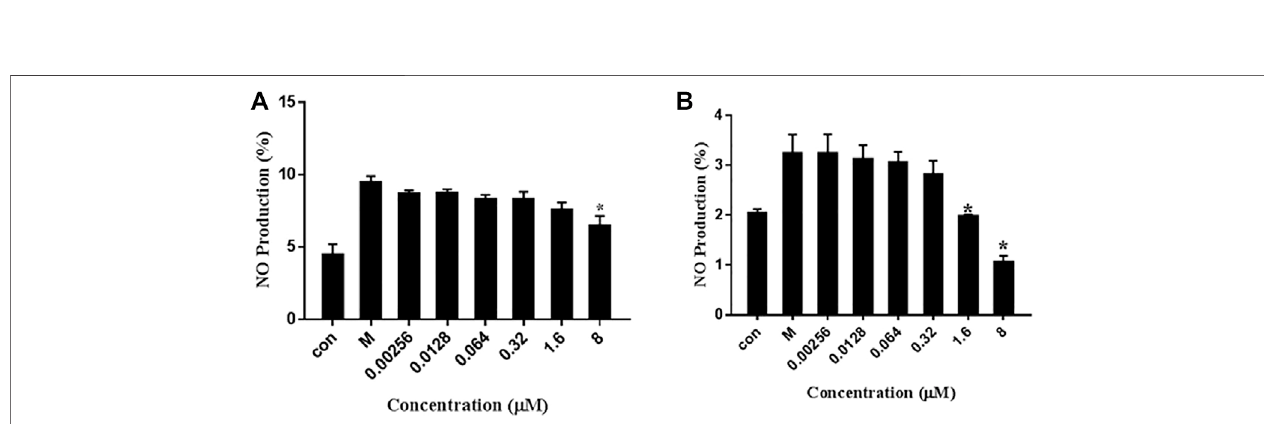
Frontiers in Pharmacology |